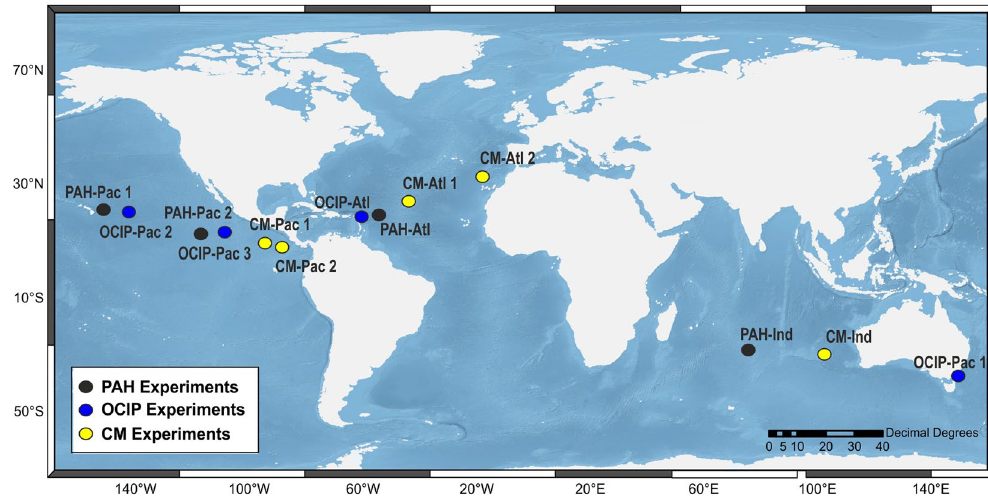
Figure 1. Location of the experiments. During the Malaspina circumnavigation on board of R/V Hesperides, natural communities from the deep chlorophyll maximum were challenged with the three different pollutant mixtures, polycyclic aromatic hydrocarbons (PAHs, black), organochlorine pesticides (OClP, blue), and complex chemical mixtures (CM, yellow). The map has been generated with ArcGIS, version 10.4